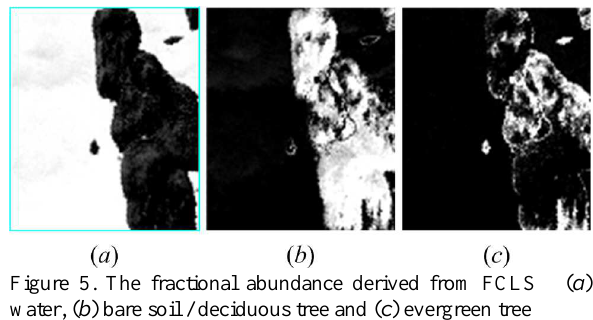
Figure 5. The fractional abundance derived from FCLS ( a ) water, ( b ) bare soil / deciduous tree and ( c ) evergreen tree